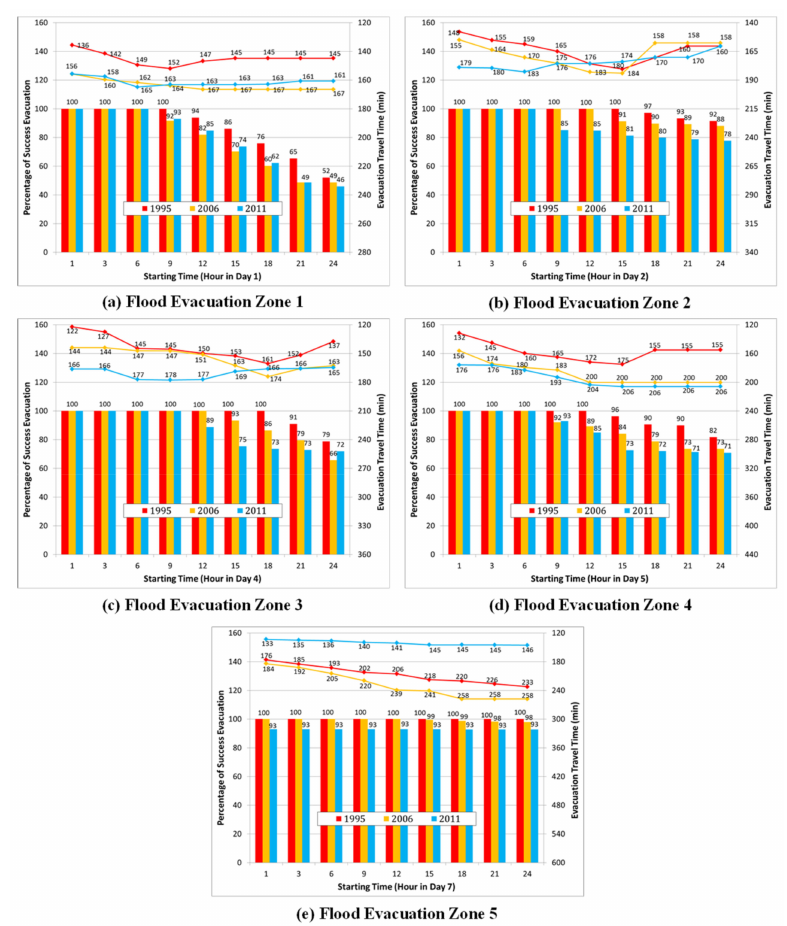
Figure 7. Computational results of emergency flood evacuation